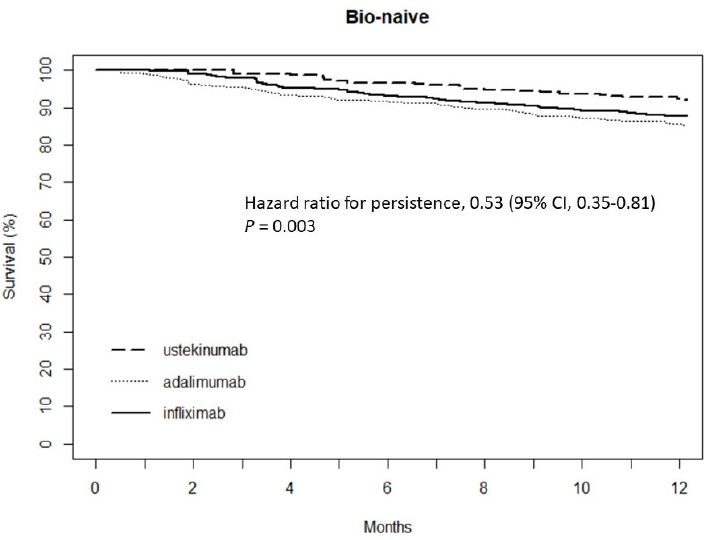
Figure 1. Comparison of persistence between anti-TNF inhibitors and ustekinumab in bio-naïve CD patients.